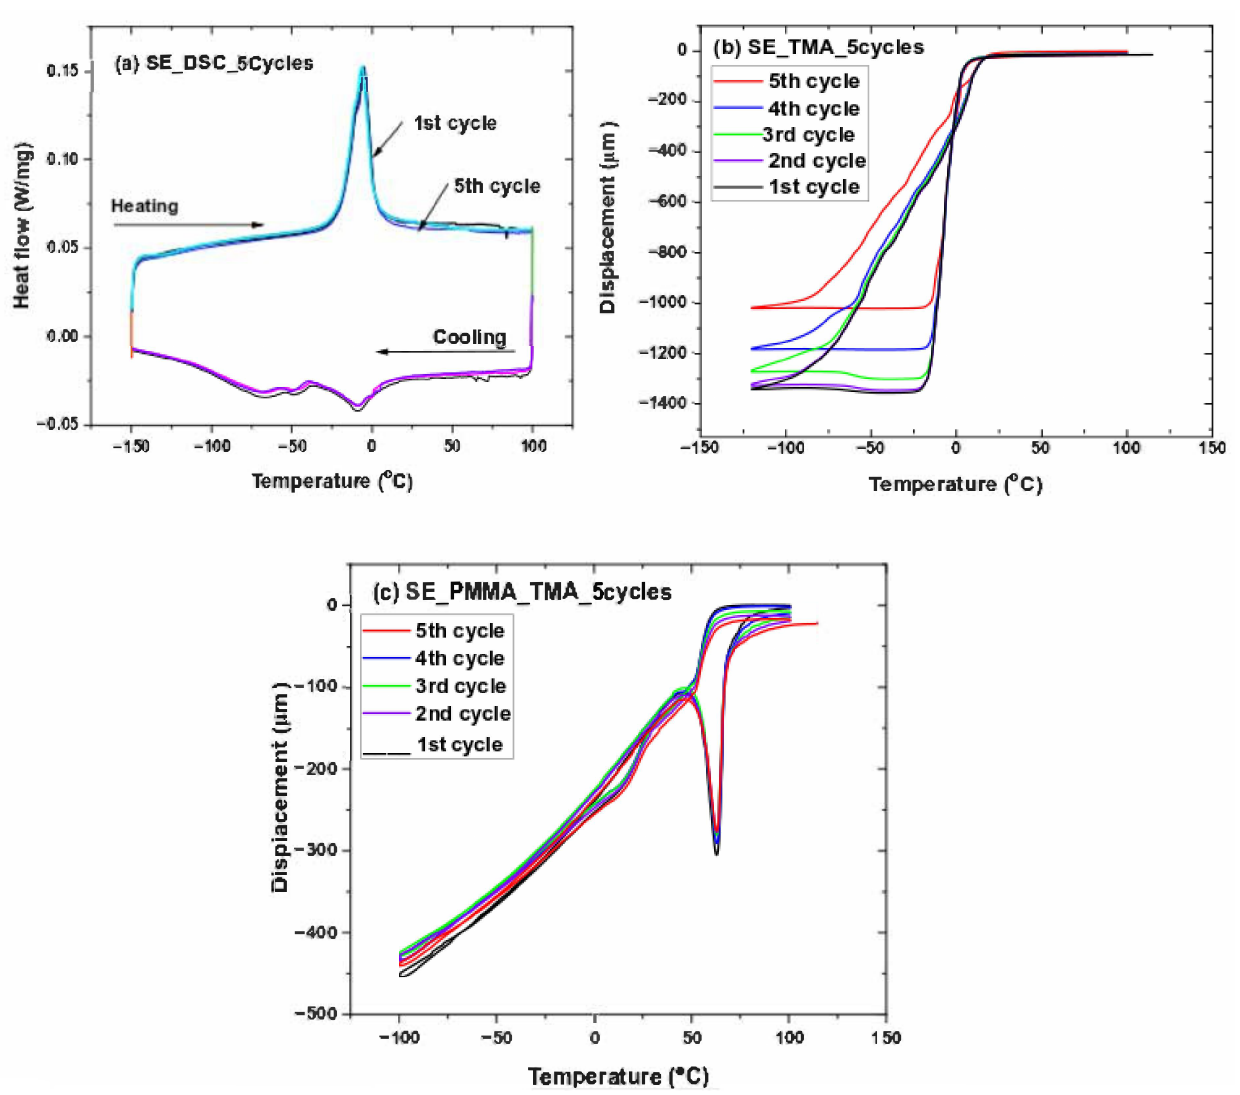
Figure 10. SE multiple cycles (5th) for ( a ) DSC for SE–NiTi, ( b ) TMA for SE–NiTi, and ( c ) TMA for SE–PMMA composite displacement as a function of